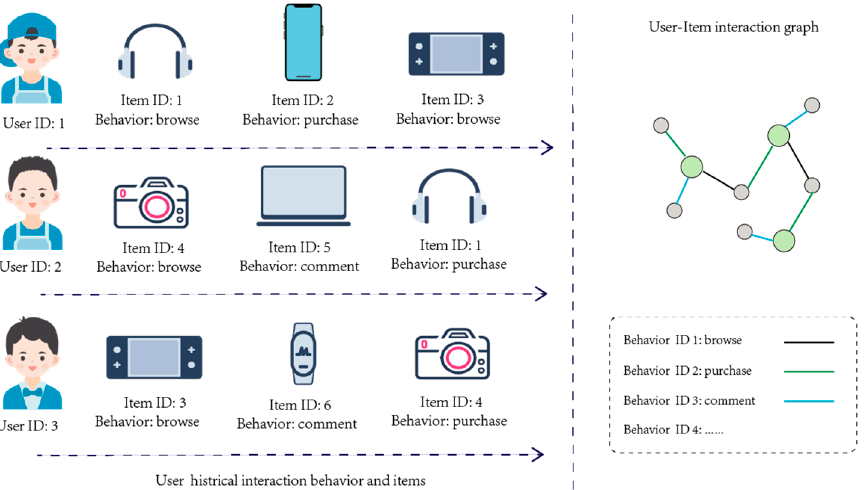
Figure 1. Illustration of the user–item interaction knowledge graph. The users’ historical interaction records can be used to construct a user–item interaction knowledge graph. The interaction behavior can be regarded as the semantic relationship between nodes.